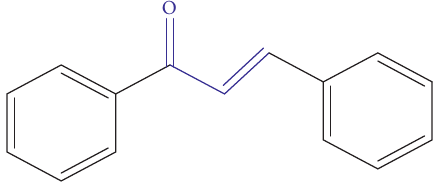
Figure 1: General structure of chalcone.